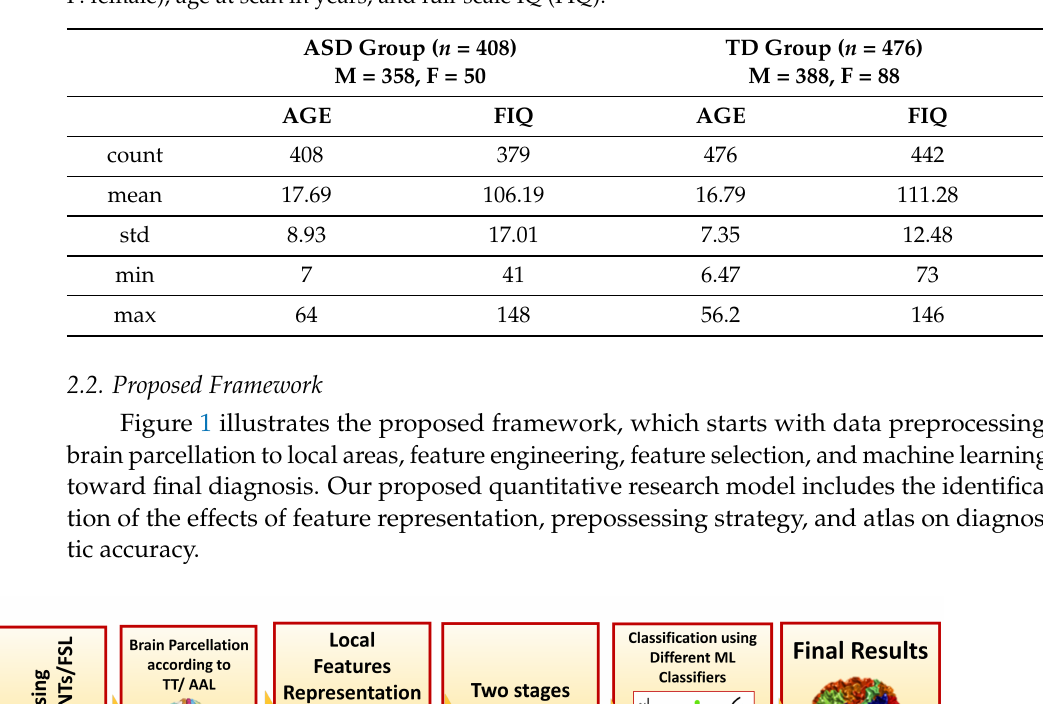
Table 1. Demographics summary of the 884 subjects used in this study, showing sex counts (M: male, F: female), age at scan in years, and full-scale IQ (FIQ).